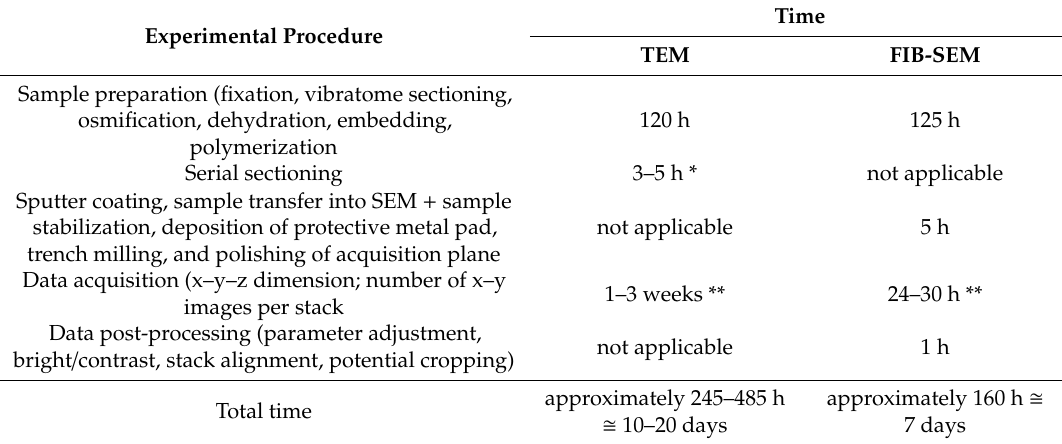
Table 3. Tissue processing for TEM and